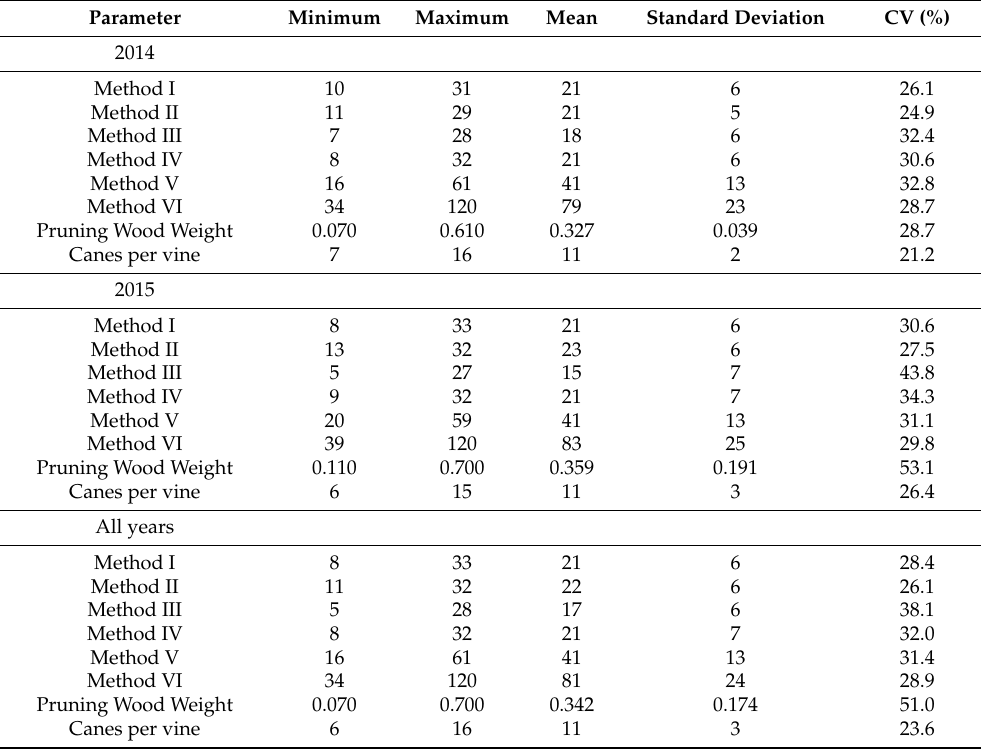
Table 5. Descriptive statistics of measurements for the Syrah cultivar.